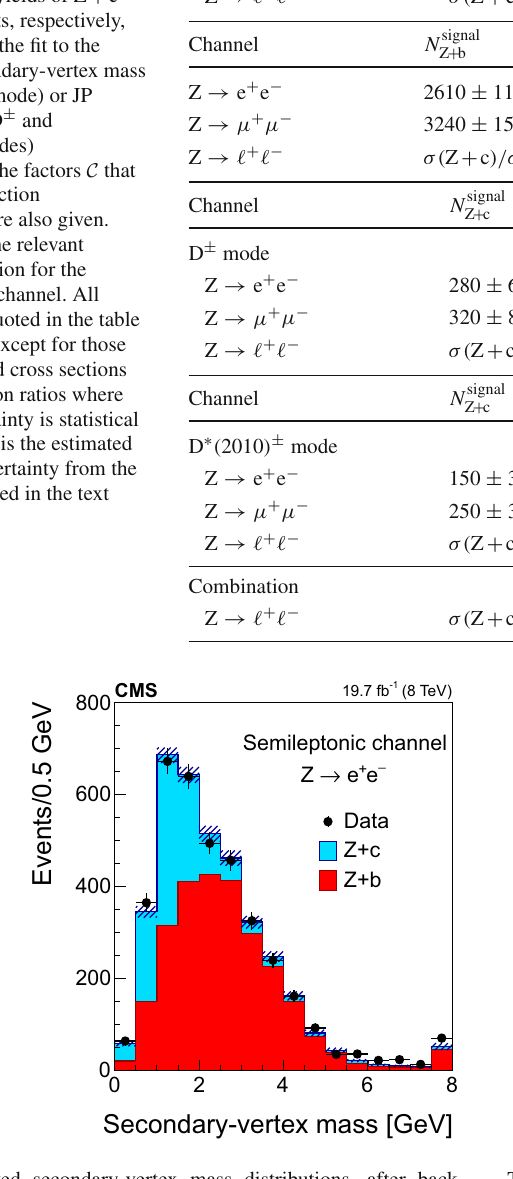
Their normalization is adjusted to the result of the signal extraction fit. Vertical bars on data points represent the statistical uncertainty in the data. The hatched areas represent the sum in quadrature of the statistical uncertainties of the templates describing the two contributions (Z +